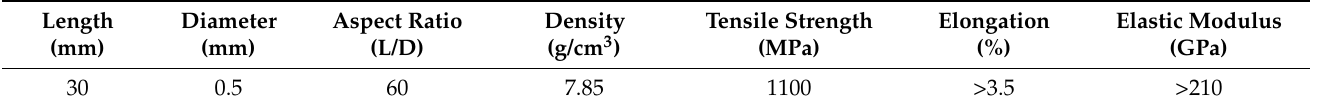
Table 1. Physical properties of SF.